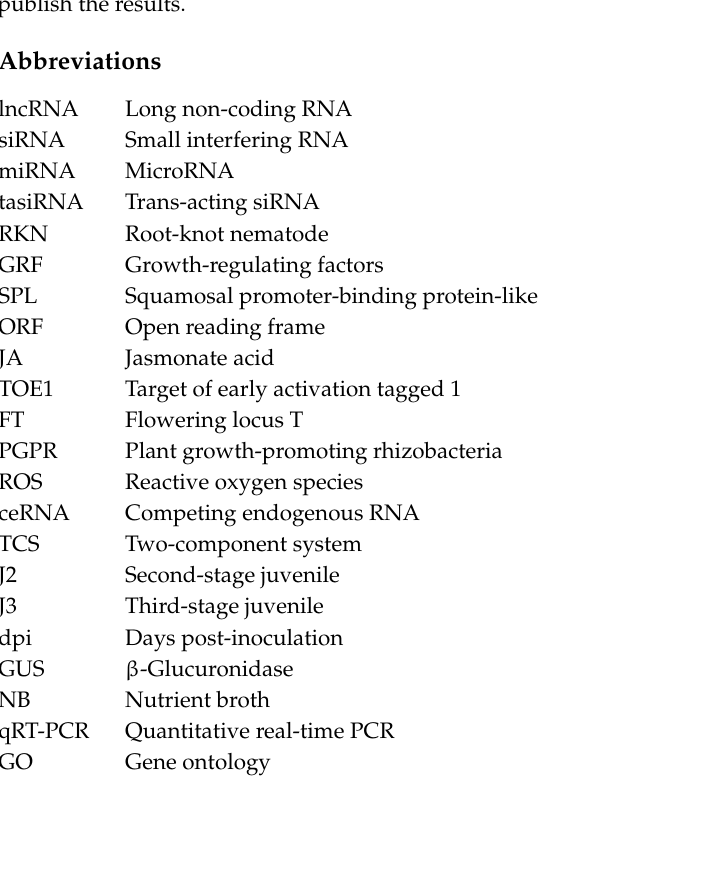
Table S1: The primers sequences used in this study; Table S2: The di ff erential expression of lncRNAs in this study; Table S3: The GO terms and related genes in this study; Table S4: The KEGG pathway and related genes in this study; Figure S1: Structural feature and expression analysis of tomato lncRNAs; Figure S2: RT-PCR confirmation of tomato lncRNAs. Lane 1-12 means selected